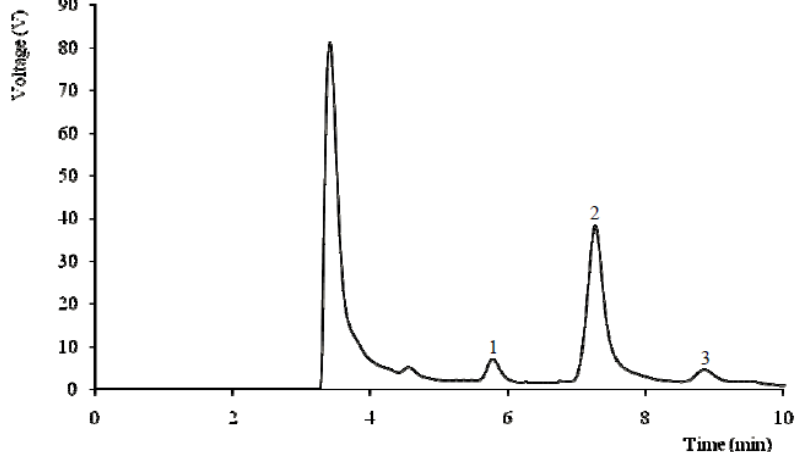
Figure 1. Individual sugars chromatogram of Lentinus tigrinus : 1-mannitol; 2-trehalose; 3-raffinose